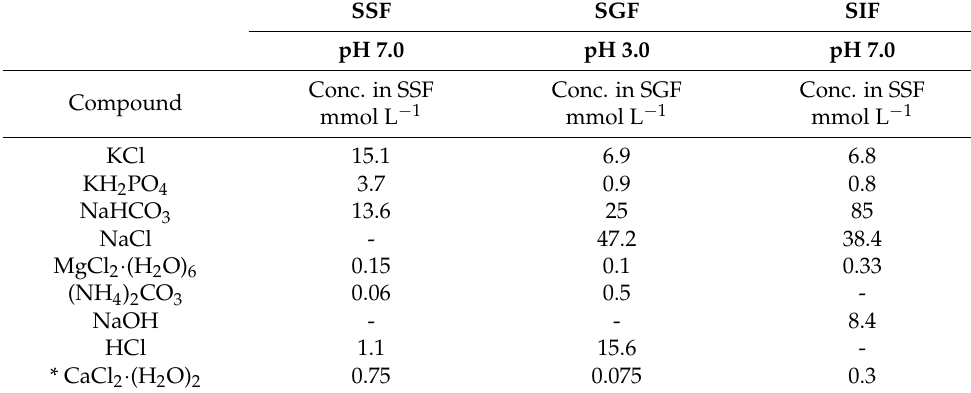
Table 1. Composition of solutions applied in in vitro gastrointestinal